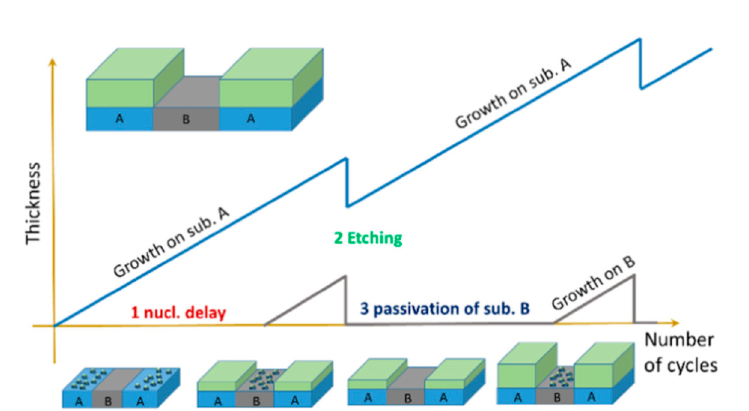
Figure 3. Schematic of an atomic layer selective deposition process as an alternative method for three-dimensional patterning. The supercycle consists of three steps, in which 1) nucleation times on two substrates (A and B) differ due to different surface chemistries on each surface; 2) a precise and selective plasma etching process is used to remove undesired growth on substrate B; and 3) chemical passivation is used to prevent material growth on substrate B. Reprinted with permission from [69].